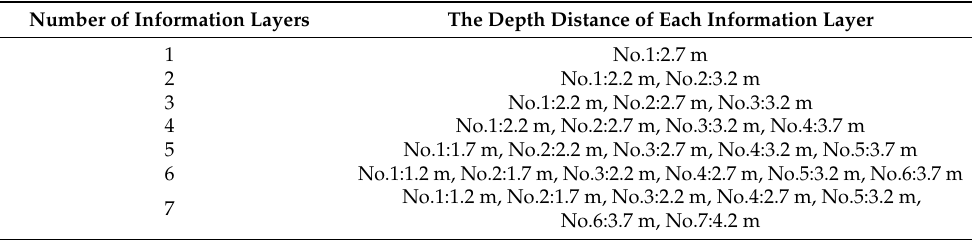
Table 10. The number of information layers and the depth distance of each information layer. Number of Information Layers The Depth Distance of Each Information